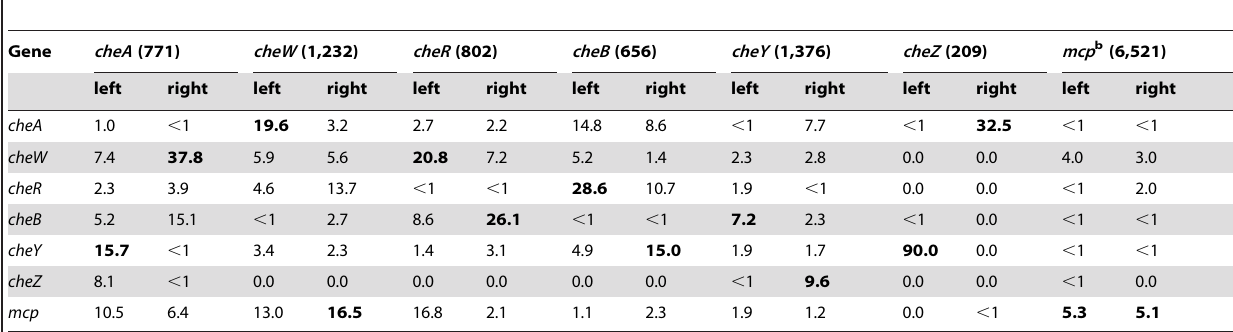
Table 1. Absolute frequencies a of a pairwise occurrence of chemotaxis genes in 527 genomes containing at least one chemotaxis